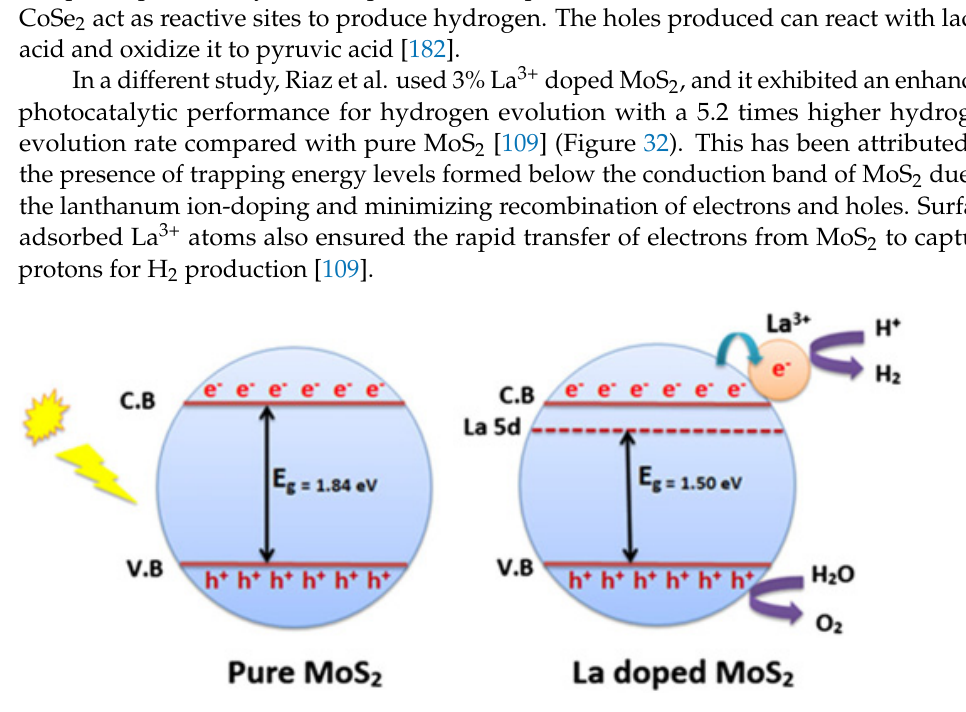
Figure 32. Schematic diagram of the proposed reaction mechanism for H 2 production using the La-MoS 2 photocatalyst. Reproduced with permission from [109].